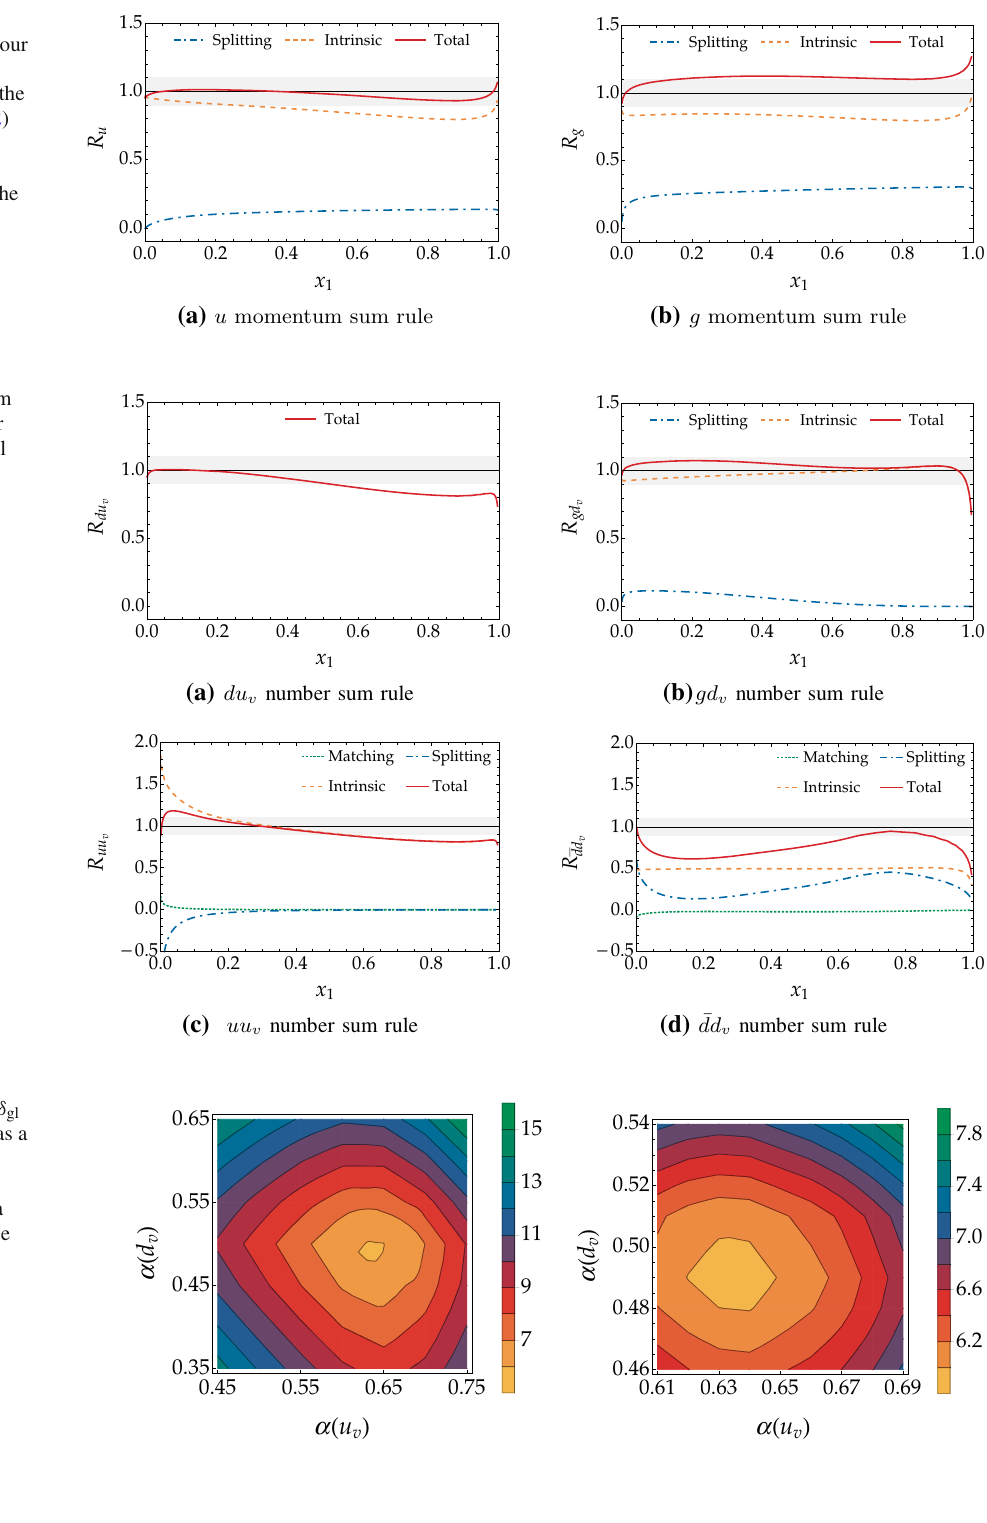
Fig. 4 Momentum sum rule ratios for the first iteration of our model, taking into account number effects (explained in the second paragraph of Sect. 5.2) and the modified phase space factor given by (22) and (23). The corresponding plots for the original model are shown in Fig. 1